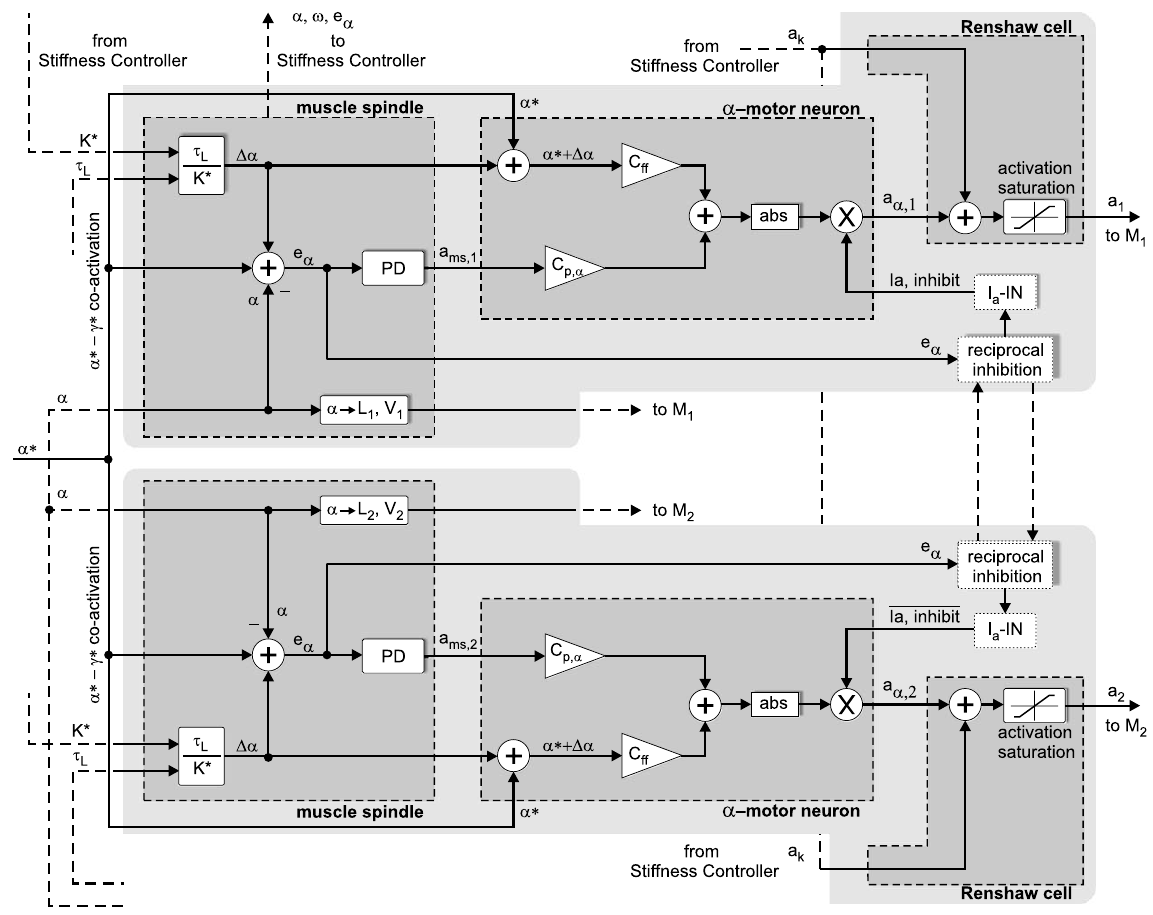
Fig. 5. Schematic of the bio-inspired position controller for the antagonistic joint setup. In dependence of the joint position error ( e α ) the reciprocal inhibition block activates, through the I a -IN, either the position controller on the top (muscle 1) or the one on the bottom (muscle 2). A reference value is sent to both muscle spindle and α -motor neuron ( α ∗ - γ ∗ co-activation). A position offset ( (cid:3)α ) is generated when a load ( τ L ) is applied to the output and added to the set points. The muscle spindle works as transducer, comparator and controller for the joint position. The control signal generated in the muscle spindle is amplified by the α -motor neuron and added to a feed-forward position signal. The resulting activation is then summed to the activation coming from the stiffness controller ( a k ), saturated to 1 ( Renshaw cell ) and sent to the